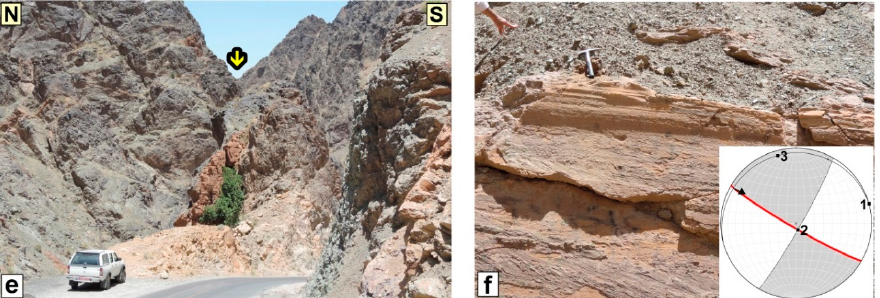
Figure 5. Structural evidence of the western parts of the South Birjand fault (see the locations on Figure 1d). ( a ) The four sub-parallel segments of the fault. ( b ) Fault segments separate different rock units: Qt = Quaternary sediments; Pes = Paleocene flysch; Pd = upper Cretaceous Peridotite; KuSh = upper Cretaceous flysch. ( c ) Outcrop of the fault between the Quaternary alluvial deposits and Cre-